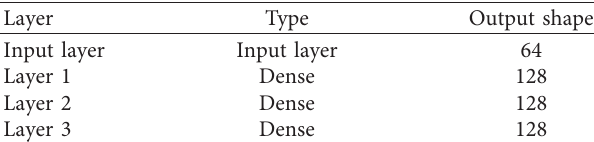
Table 1: A summary of both top and bottom twin networks of the proposed Siamese neural network model.